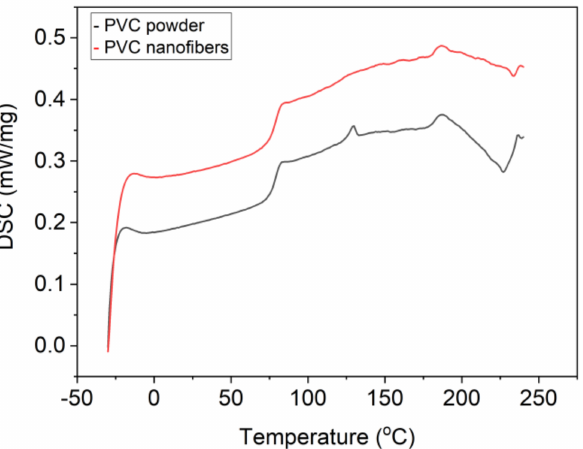
Figure 4. Differential scanning calorimetry thermogram of PVC powder and PVC nanofibers [81].